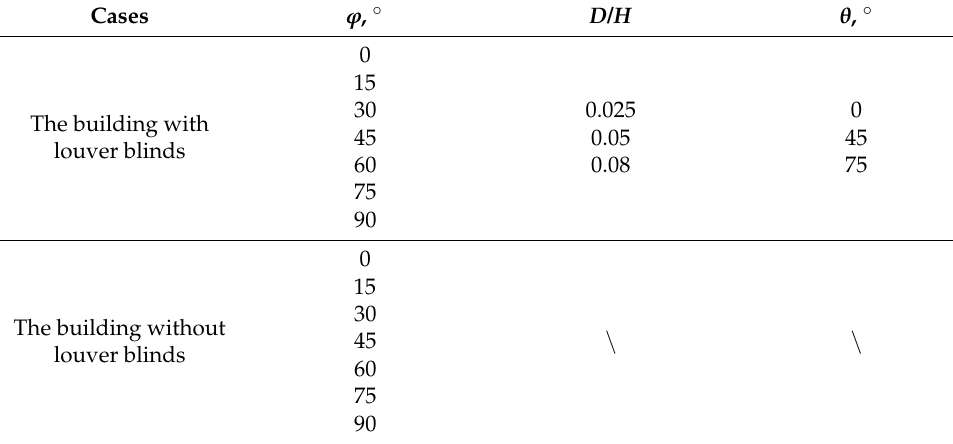
Table 2. The louver blinds geometry for the CFD